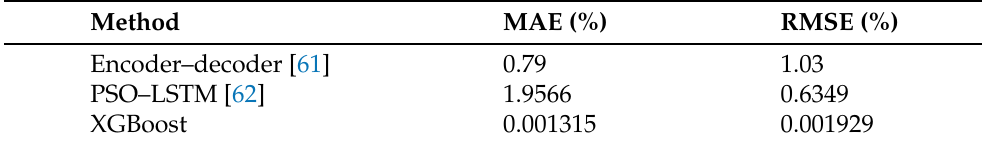
other methods. Table 6. Performance analysis of the estimation results using the proposed method.